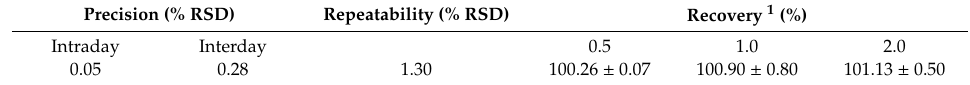
Table 5. Validation parameters of the developed method for quantifying TPC from almond residues.